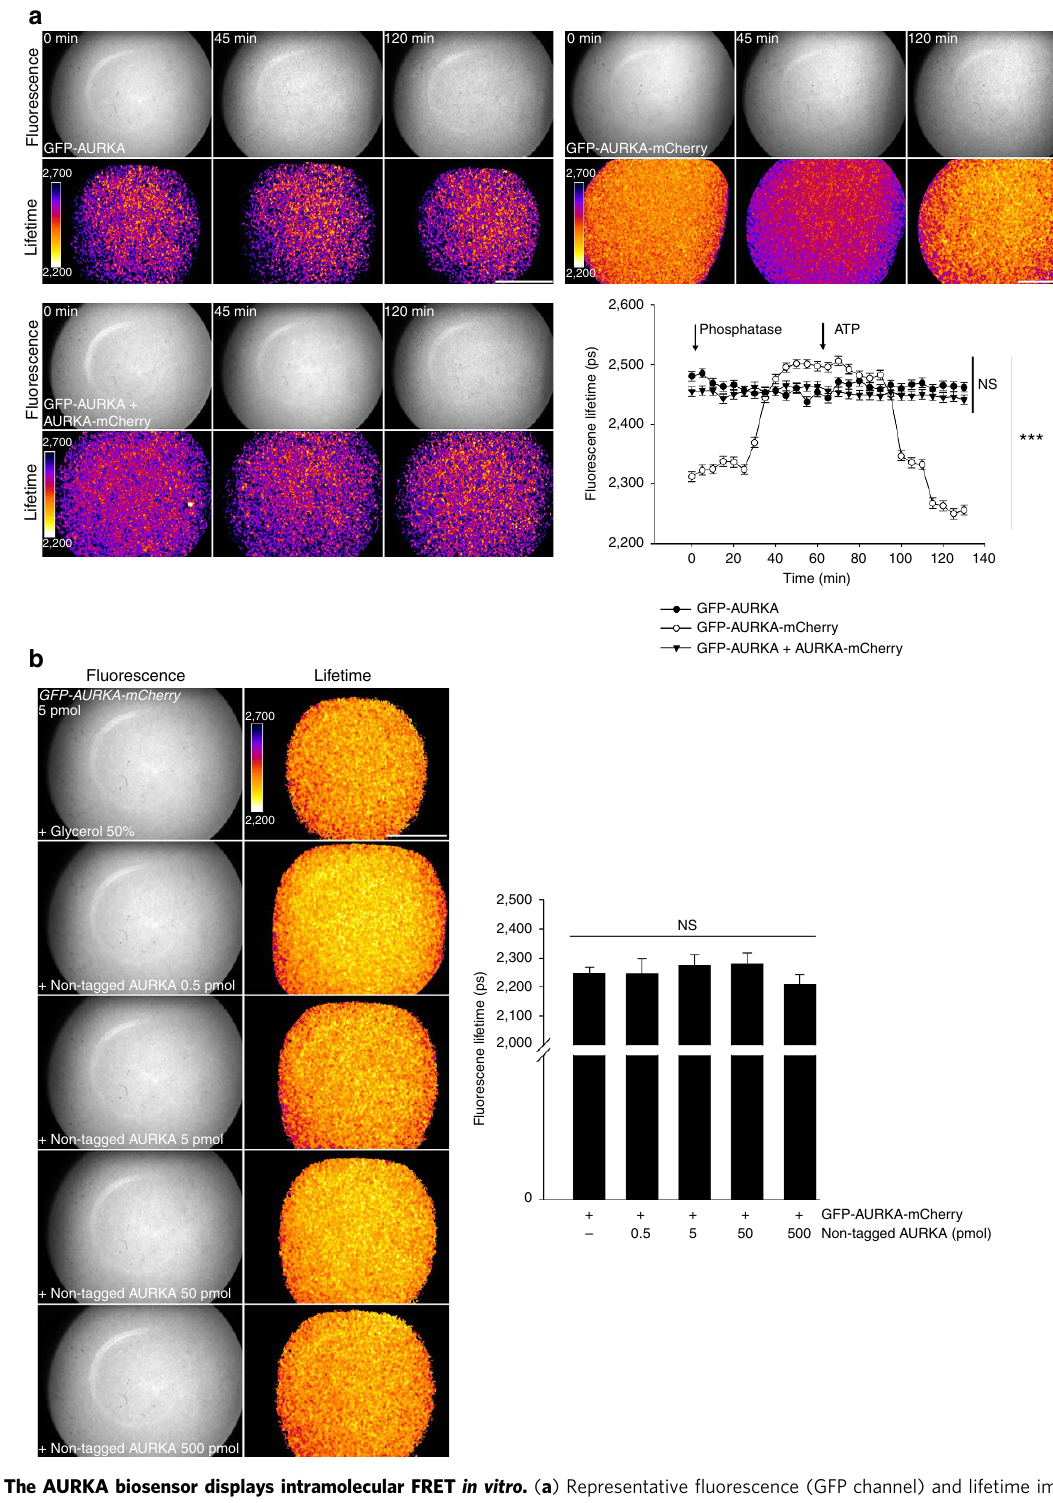
Figure 3 | The AURKA biosensor displays intramolecular FRET in vitro . ( a ) Representative fluorescence (GFP channel) and lifetime images taken at selected time points, and corresponding quantification of the in vitro FLIM analysis of the lifetime of EGFP from GFP-AURKA, GFP-AURKA-mCherry or GFP-AURKA and AURKA-mCherry samples incubated at 30 (cid:2) C with l PP for 1h, and then treated with ATP for 1h. Images were acquired every 5min. Data represent means ± s.e.m. of three independent experiments. *** P o 0.001 against each time point in the corresponding ‘GFP-AURKA’ condition. Statistical test: two-way ANOVA. Arrows: addition of l PP/ATP. ( b ) (Left panels) Representative fluorescence (GFP channel) and lifetime images of GFP-AURKA-mCherry incubated with the indicated quantities of untagged AURKA. (Right panel) Histograms show the corresponding quantification of the lifetime of EGFP obtained from the GFP-AURKA-mCherry protein treated as in the left panels. Data represent means ± s.e.m. of three independent experiments. Comparisons were made against the ‘ þ glycerol 50%’ condition. Pseudocolour scale: pixel-by-pixel lifetime. Scale bar, 5 m m. NS, not significant. Statistical test: one-way